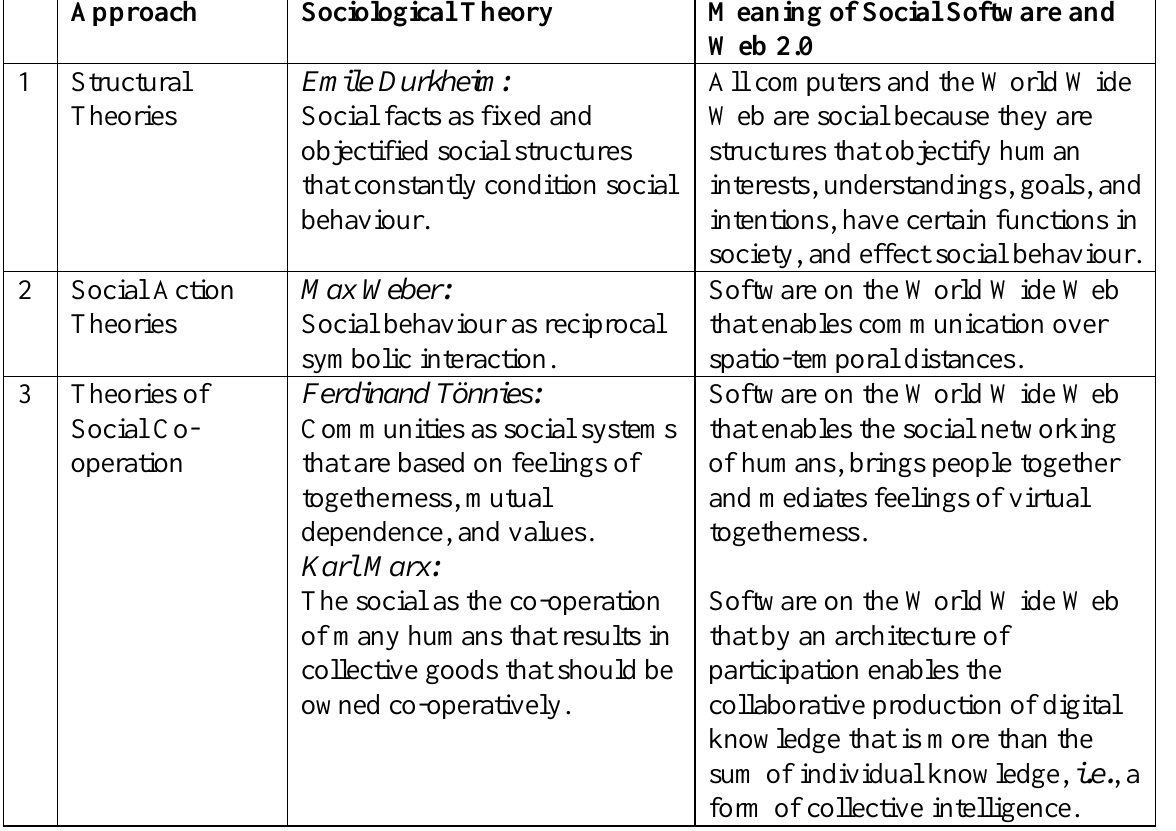
Table 1. Different understandings of Social Software and Web 2.0 from different sociological